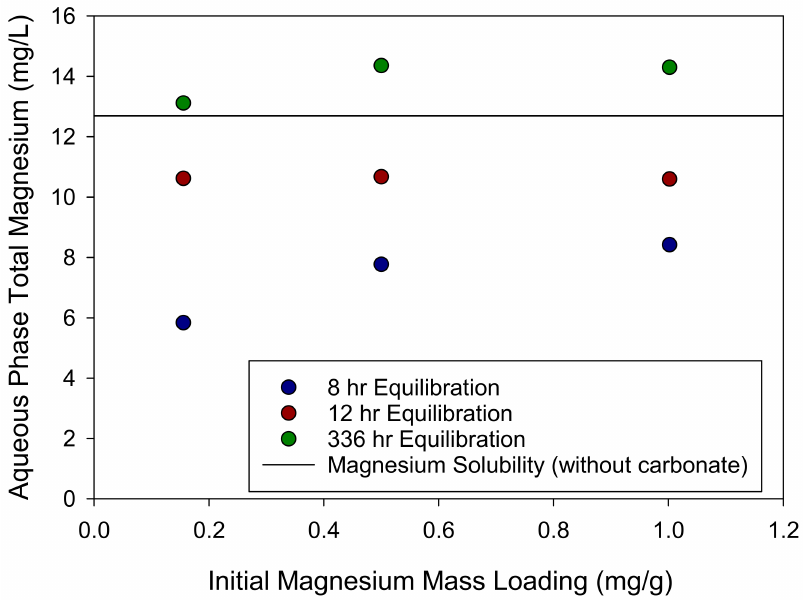
Figure 1. Measured values of total magnesium in the aqueous phase for the experiments conducted to support development of the conceptual